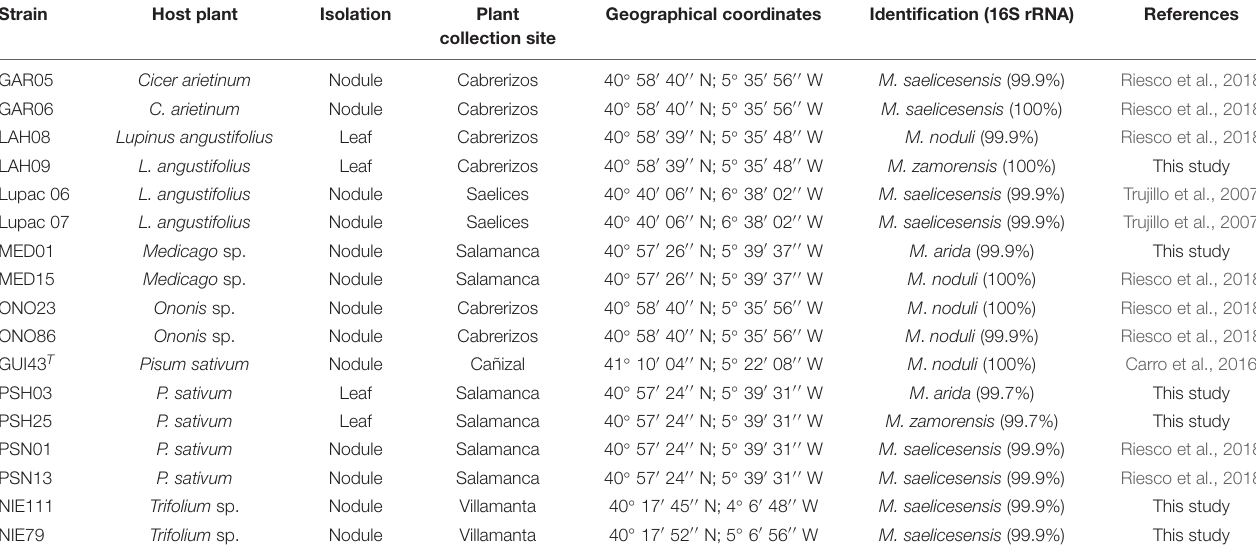
TABLE 1 | Source of strains used in this study and identification according to the 16S rRNA gene sequence. Strain Host plant